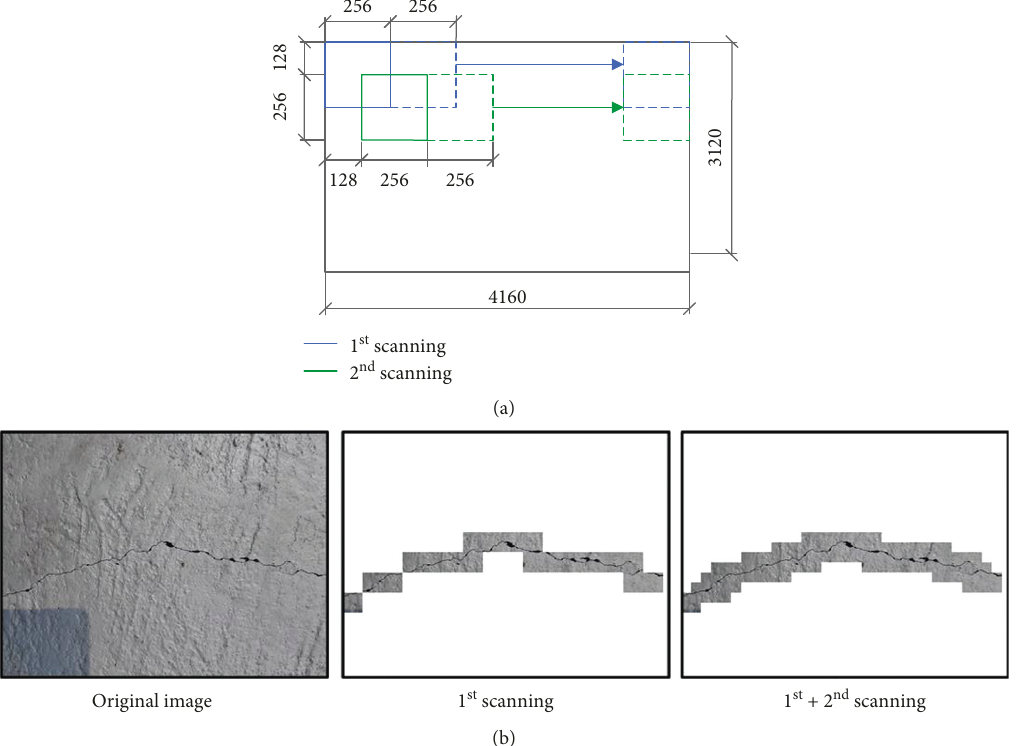
Figure 9: Crack detection using exhaustive search: (a) sketch; (b) detection result.